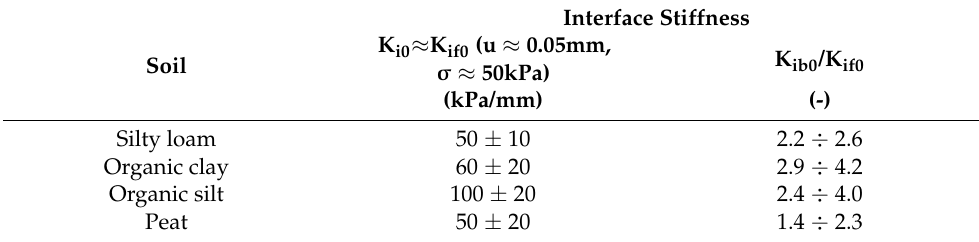
Table 8. Interface stiffness characteristics for rough concrete–soil